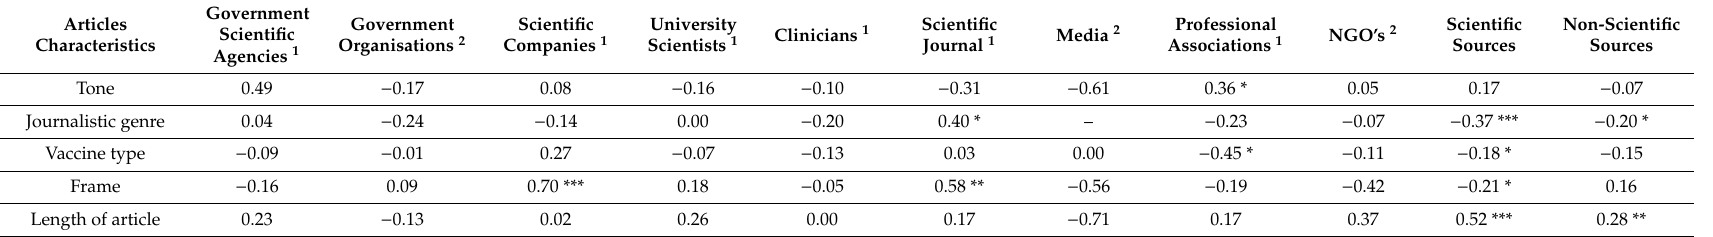
Table 3. Correlations among source types and the article characteristics (tone, journalistic genre, vaccine type and frame). Articles